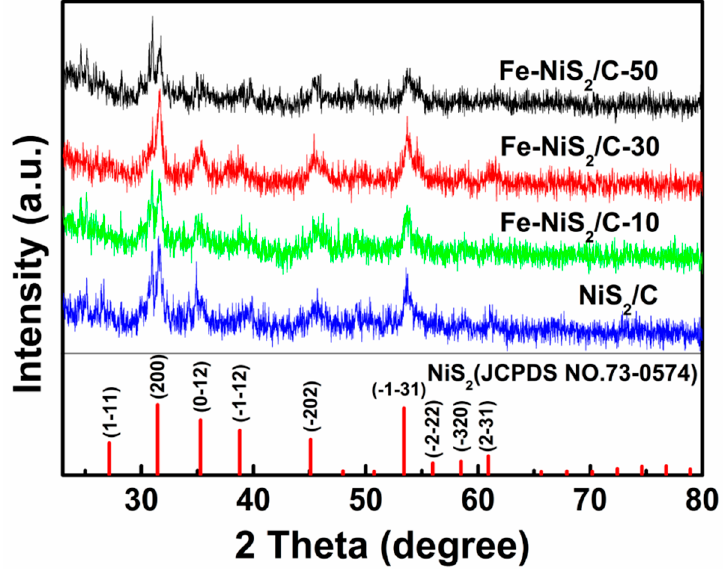
Figure 2. XRD profiles for different investigated samples.